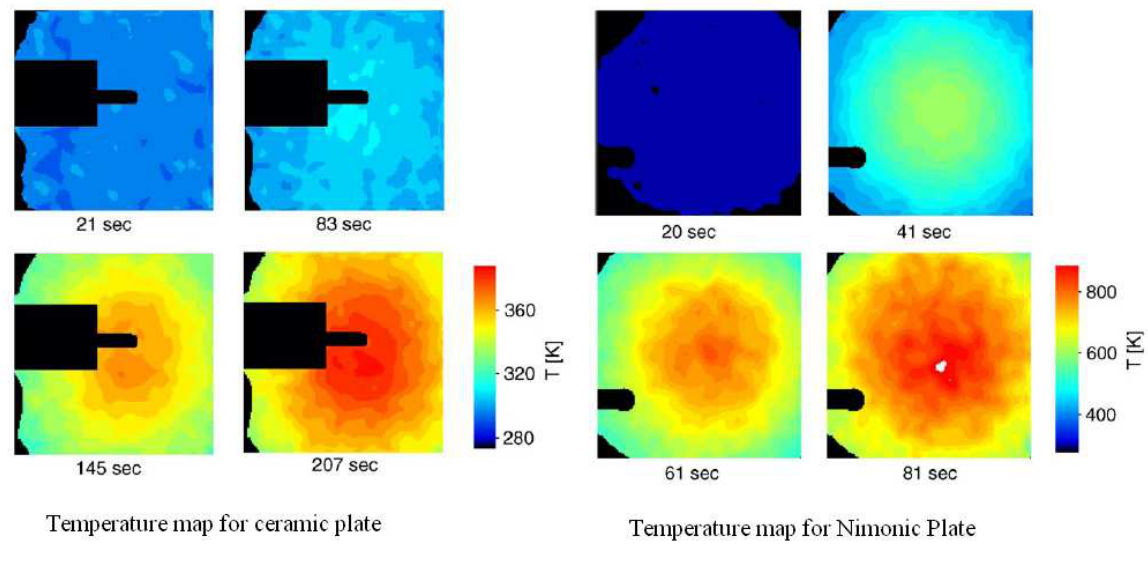
Figure 42. 2D temperature map for ceramic and nimonic plate at different times. Taken from Heyes et al . [34].